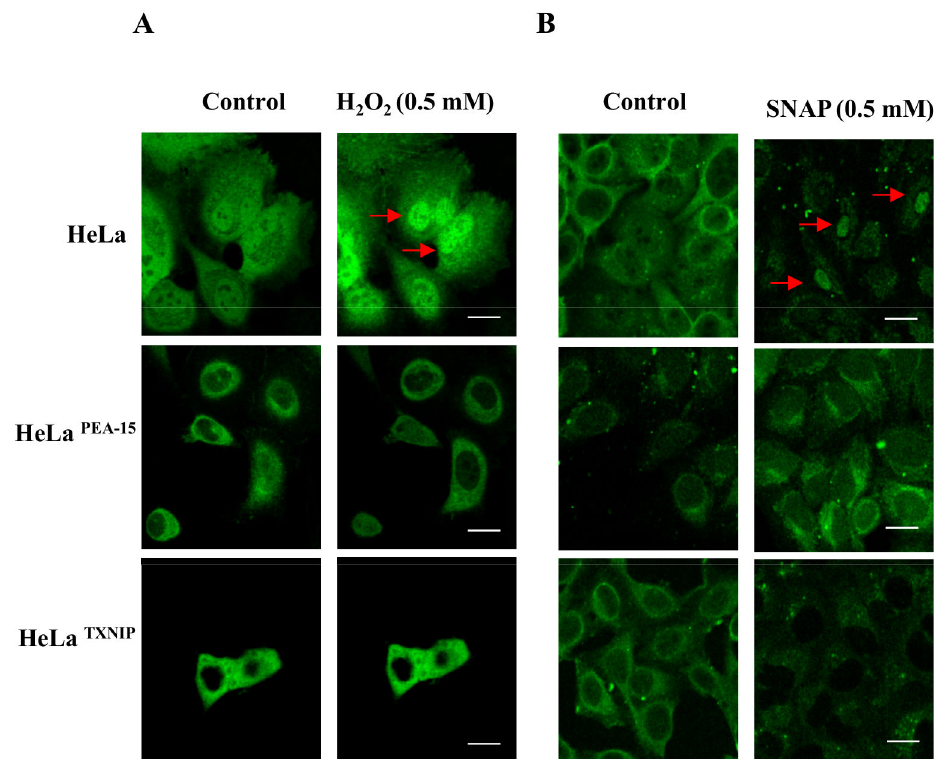
Figure 7. Confocal microscopy based analysis to determine a time-dependent sub-cellular localization of TRX-1 in HeLa cells. ( A ) Wild-type HeLa cells, HeLa cells expressing PEA-15, and HeLa cells expressing TXNIP were plated two days prior to experiment. Transient transfections with pEGFP-C1_TRX-1 were performed on day one. On day two, cells were assayed for TRX-1 sub-cellular localization. Cells were kept in a heated stage chamber (37°C) of the confocal microscope, and a first scanning was recorded to serve as control. After that, media was replaced and H O was added to a final concentration of 0.5 mM. Subsequent 2 2 scanning were performed at every 15 min up to 2 h. Bar = 20µm. ( B ) Cells were transfected with pEGFP-C1-TRX-1, treated with SNAP (0.5 mM) for 2 h at 37°C and submitted to indirect immunofluorescence for GFP, to show the localization of TRX-1 in HeLa cells. Red arrows indicate TRX-1 nuclear accumulation. doi: